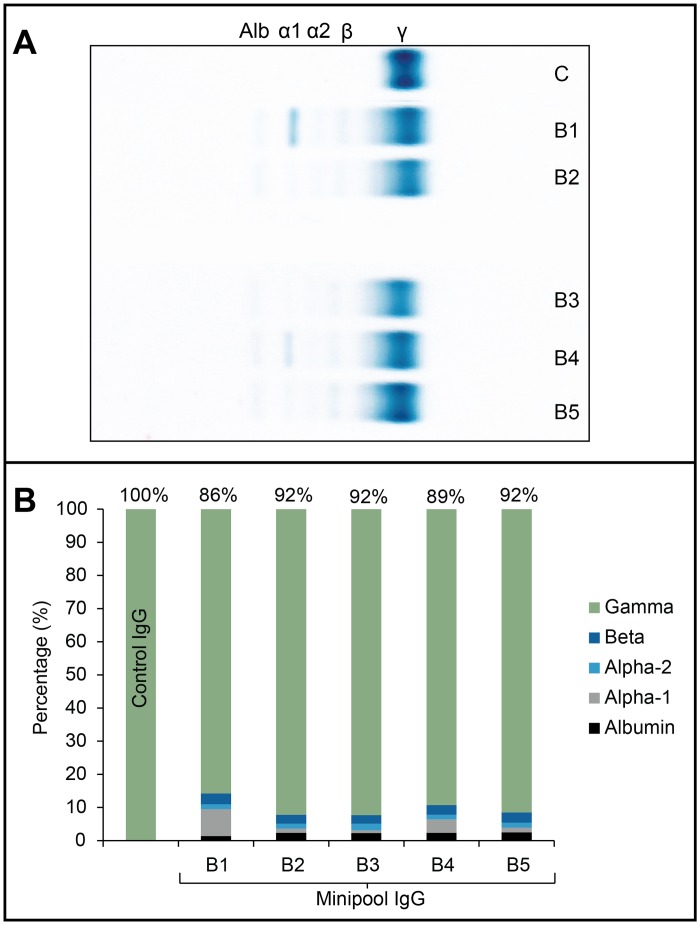
Zone electrophoresis.A: Patterns of 5 consecutive batches of minipool IgG-enriched plasma fractions (Minipool IgG batches B1 to B5) and control IgG (C) showing the separation between albumin (Alb) and alpha-1 (α-1), alpha-2 (α-2), bêta- (β) and gamma- (γ) proteins. B: densitographic analysis showing the percentage (%) of albumin, alpha-1, alpha-2, bêta, and gamma proteins in 5 batches (B1–B5) of minipool IgG. Control: control IgG.